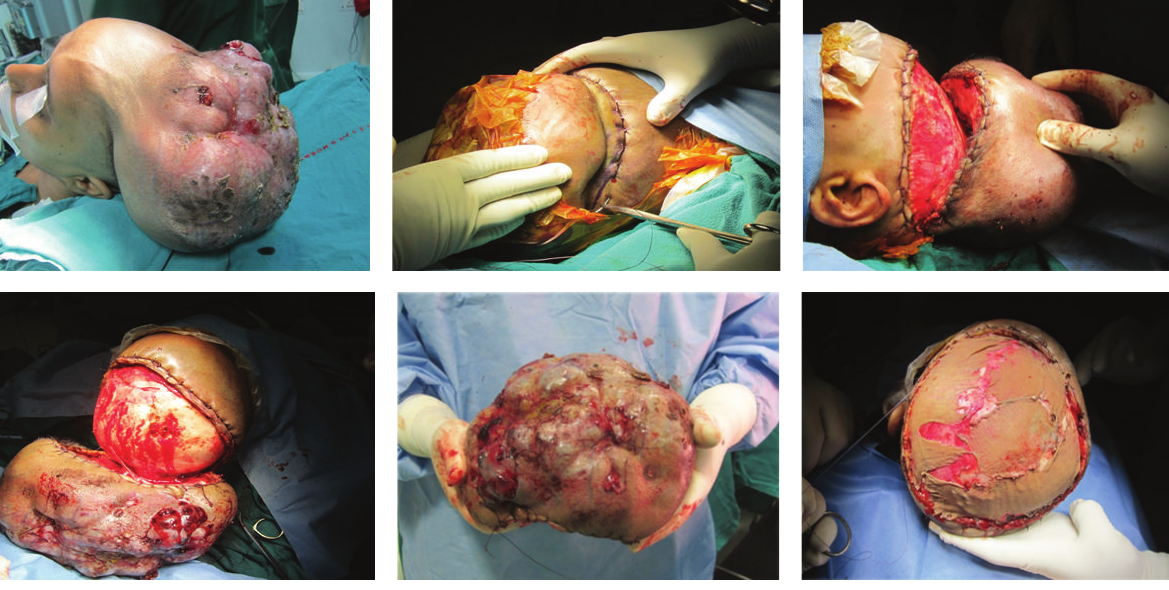
Figure 3: Surgical excision of tumour and coverage of scalp with split thickness skin graft. Note that, with the use of hemostatic sutures, blood loss could be minimised.